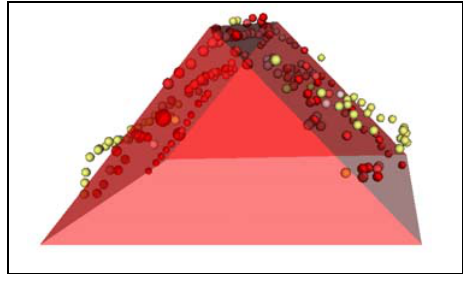
Figure 2. Coarse classification step: Result of a RanSaC run for a gabled roof. Outlier are depicted in yellow and inlier in red colour.